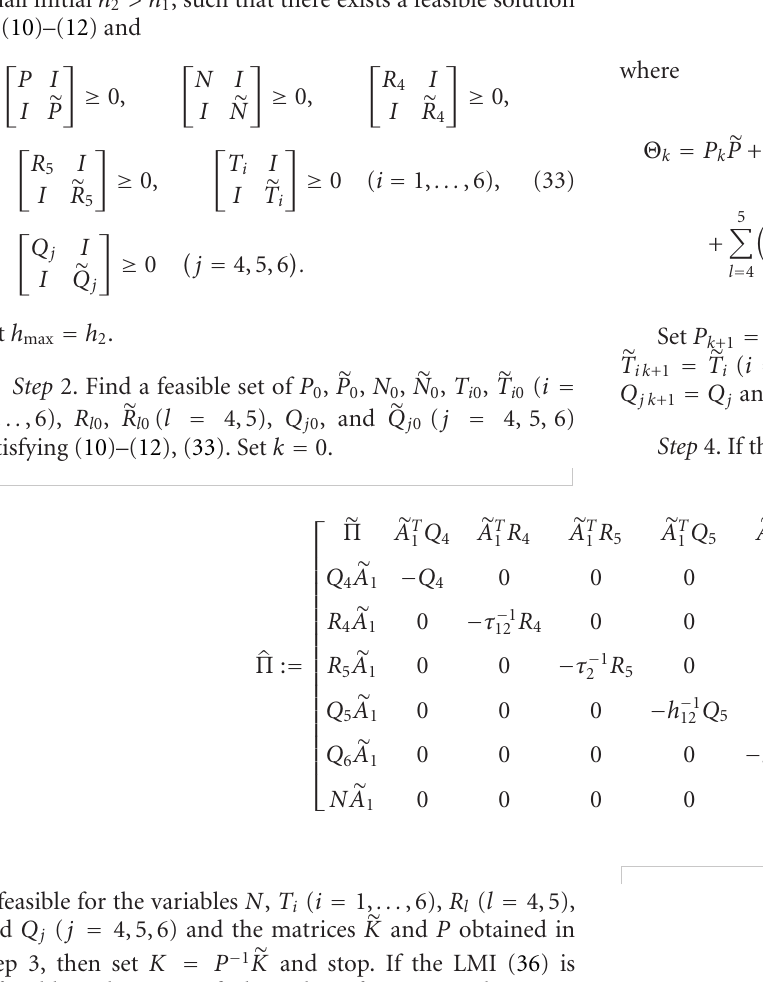
Algorithm 7 (CCL algorithm). Step 1. Choose a su ffi